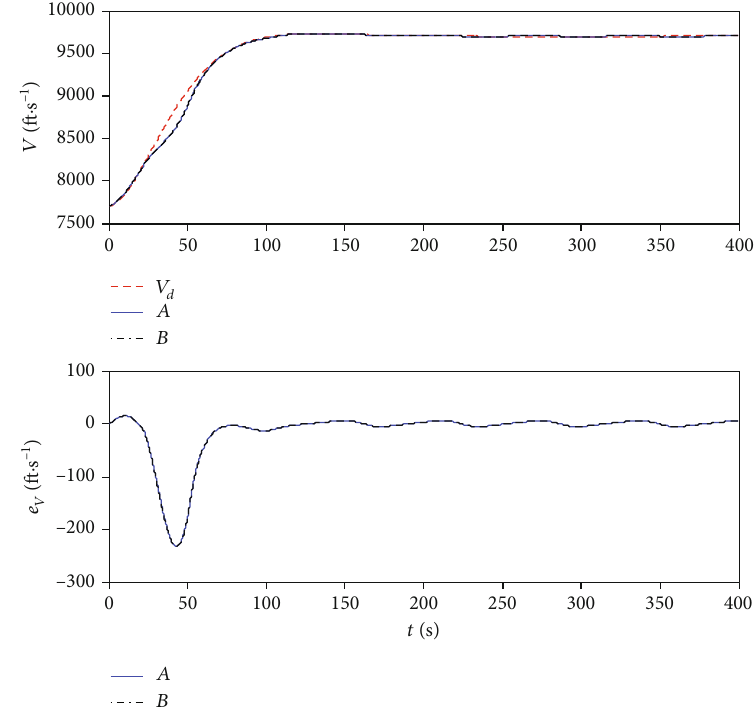
Figure 2: Curves of velocity and its tracking